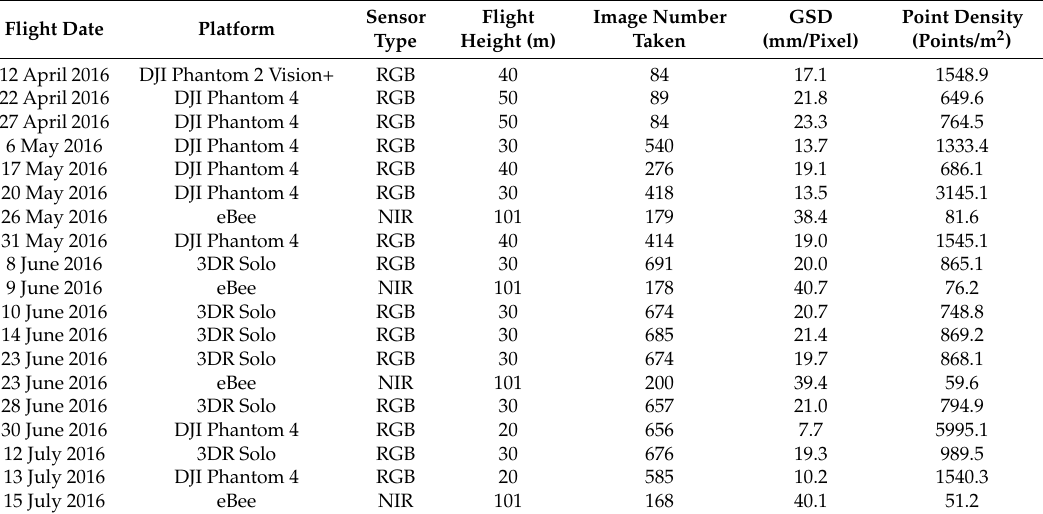
Table 2. Flight information of the UAS